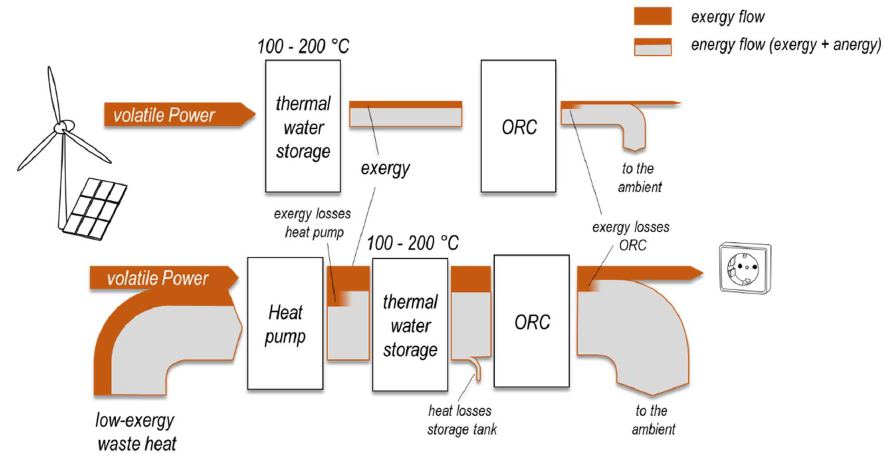
Figure 1. Exergy flow for electricity storage by means of reversible heat pump/ Organic Rankine Cycle (ORC) systems with thermal heat storage.